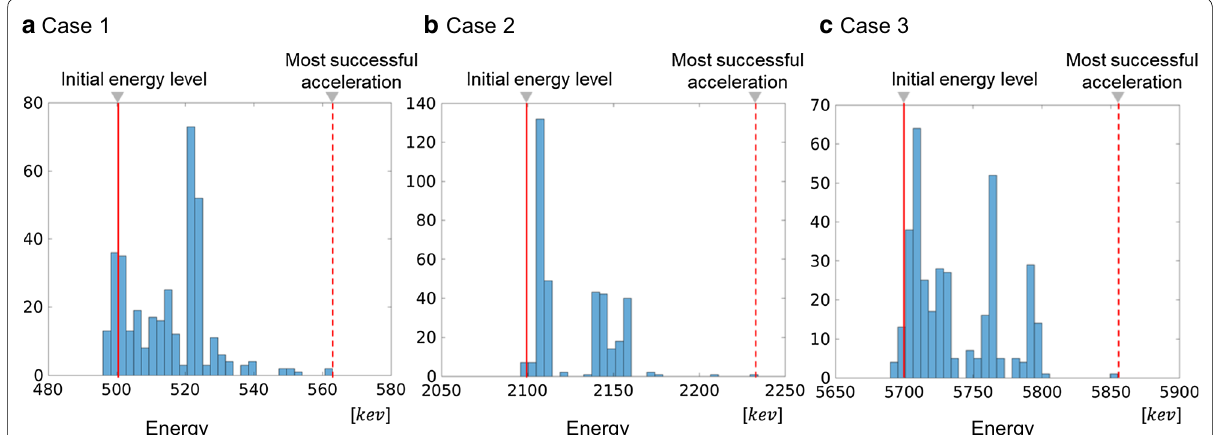
Fig. 10 Histograms of the final energy levels of 360 test particles in case 1 (500 keV-60°), case 2 (2.1 MeV-80°), and case 3 (5.7 MeV-86°). a Histogram in case 1. About one-third of the particles are accelerated by about 20 keV (energy gain by a few subpackets). Rest of the particles also gain energies less or more than 20 keV depending on the number of the wave subpackets that each particle is entrapped by. b Histogram in case 2, which forms 10 keV (energy gain by less than a single subpacket). The second peak is at (cid:31) K 50 keV (energy gain by a a distribution with the first peak at (cid:31) K ≈ ≈ 10 keV (energy gain by less than a single subpacket). few subpackets). c Histogram in case 3, which forms a distribution with the first peak at (cid:31) K ≈ 50 keV (energy gain by a few subpackets). The third peak is at (cid:31) K 100 keV (energy gained by four or five subpackets). The second peak is at (cid:31) K ≈ ≈ These distributions indicate that not only a small fraction of successful particles, but also many other particles can be accelerated with various